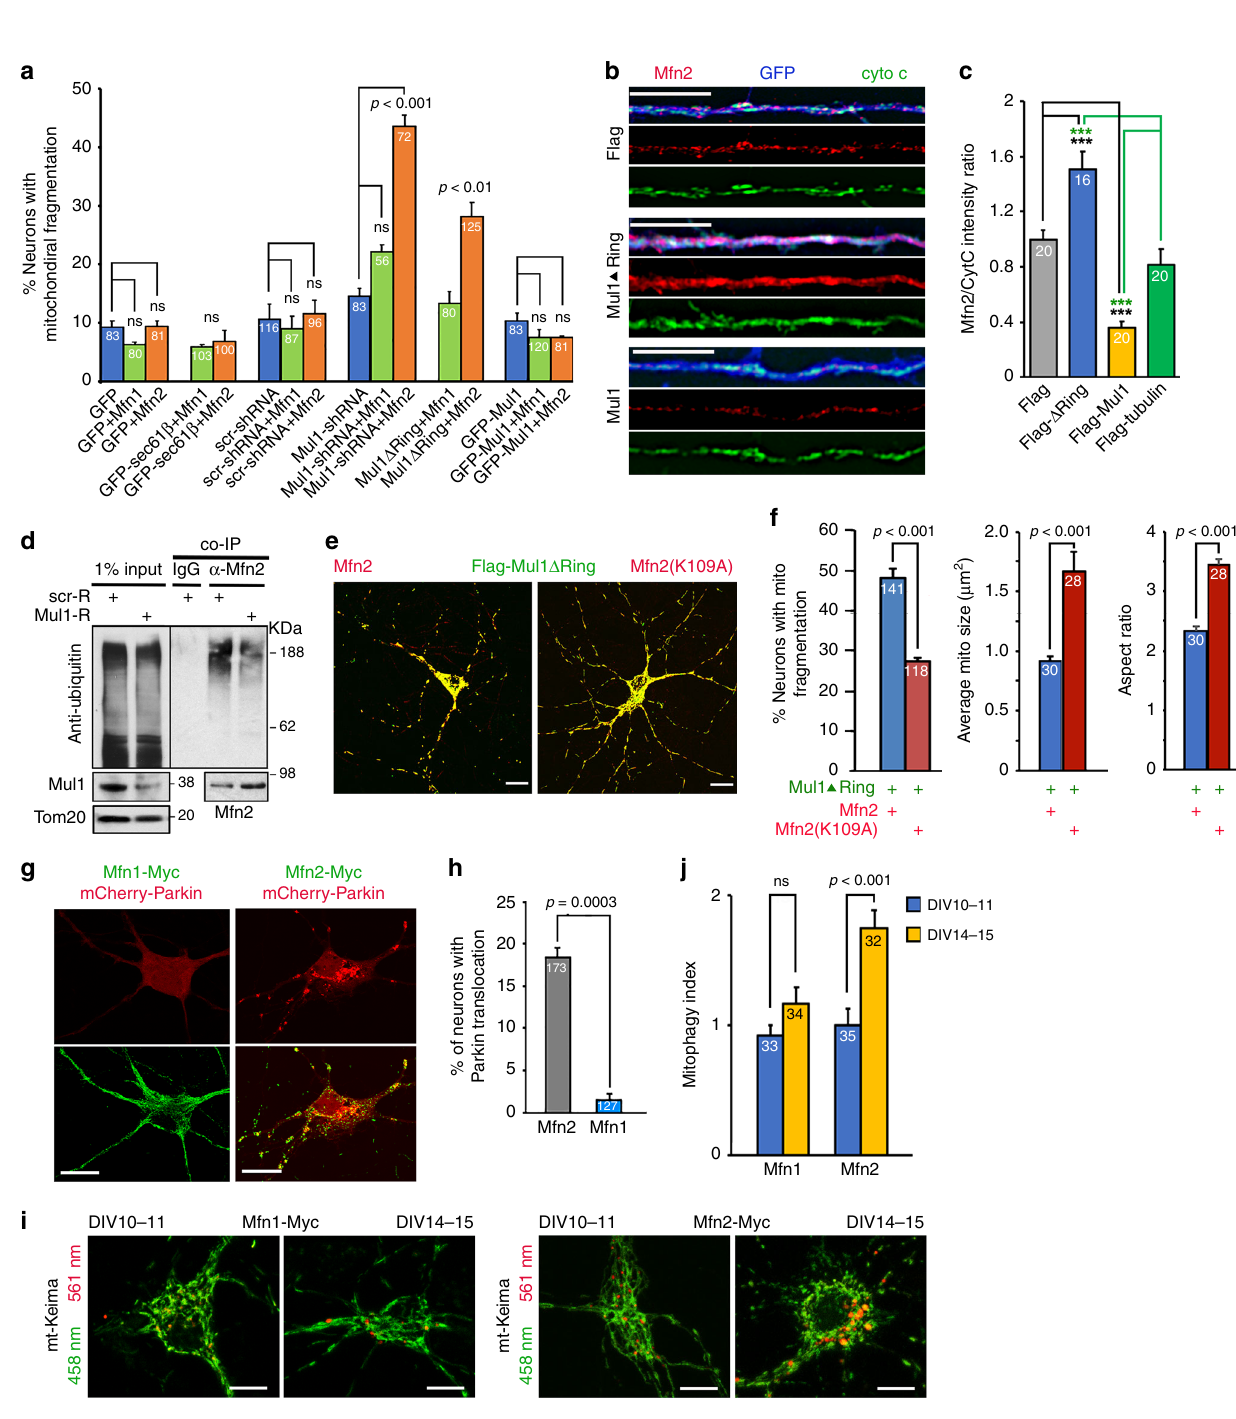
Fig. 3 Mul1 de fi ciency reduces mitochondrial Δψ m in mature neurons. Cortical neurons were co-transfected at DIV7-8 with GFP and CFP-Mito ( a ), GFP, CFP-Mito and scr-shRNA ( b ), GFP, CFP-Mito and Mul1-shRNA ( c ), CFP-Mito and Flag-Mul1 Δ Ring ( d ), GFP-Mul1-H319A ( e ), or GFP-Mul1 ( f ). Mitochondria were labeled by CFP-Mito ( a – d : blue channel) or by mitochondria-targeted GFP-Mul1-H319A ( e ) or GFP-Mul1 ( f ) (green channel). Live imaging was performed at both DIV10-11 and DIV14-15 following loading of the Δψ m -dependent fl uorescent dye TMRE (50 nm) for 20 min. Note that while neurons expressing GFP ( a ), scr-shRNA ( b ), or GFP-Mul1 ( f ) display TMRE-labeled polarized mitochondria at both DIV10-11 and DIV14-15, Mul1-de fi cient neurons ( c – e ) results in loss of TMRE staining of mitochondria at DIV14-15 ( g ), indicating mitochondrial depolarization. The edges of transfected cell bodies and proximal processes are marked with white dashed lines. TMRE mean intensity was measured and normalized to control neurons transfected with GFP at both time points. The data were analyzed from the total number of neurons shown in the bars from three experiments and expressed as mean ± s.e.m. Unpaired Student ’ s t -test was used for comparing two groups and Ordinary one-way ANOVA with Dunnett multiple comparison test for multiple comparisons. Scale Bars: 10 μ m. (Also see Supplementary Figs. 5e, f, and